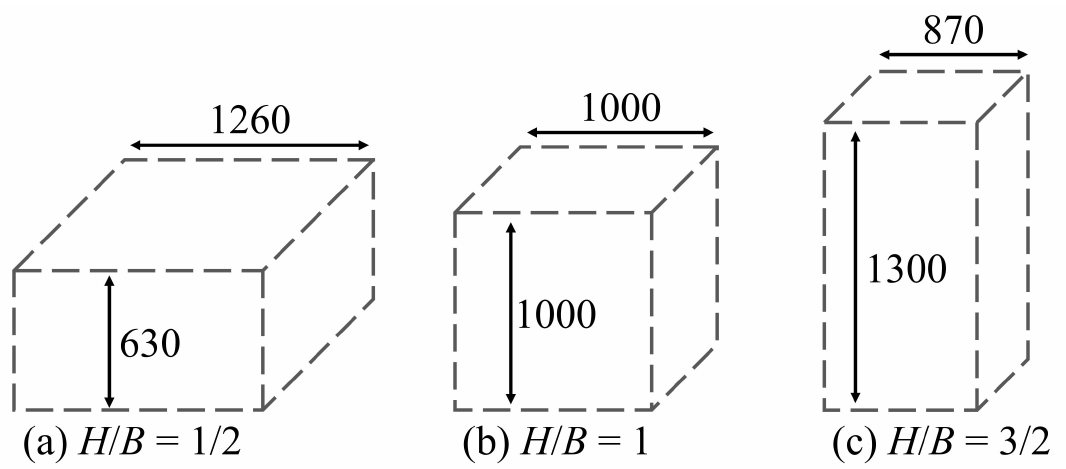
Figure 3. The three rectangular-prismatic envelopes of this research; units of